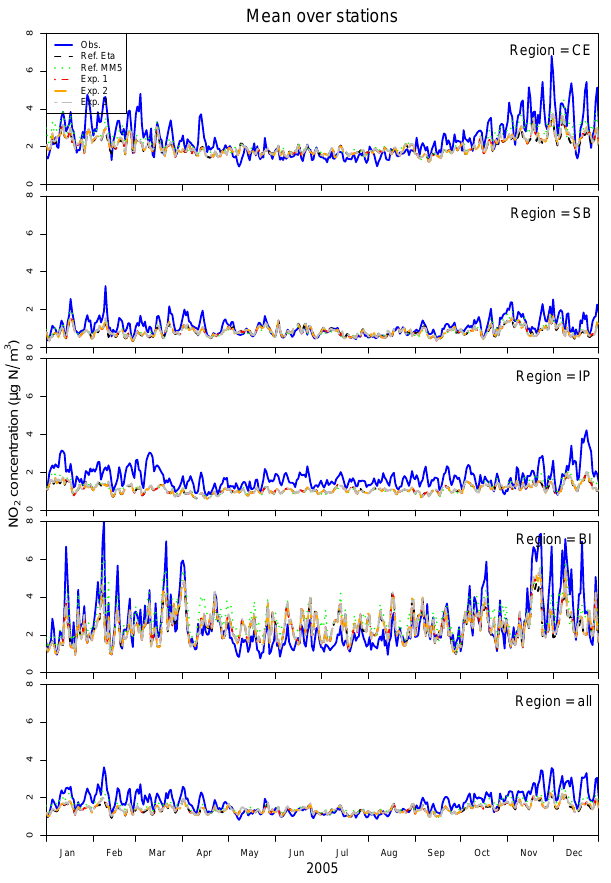
Fig. 7. Time-series of daily-averaged NO 2 concentrations for the different regions indicated in Fig. 1b. Each time-series, for observations and the modelled values from the five simulations, is shown with a distinct color and line type.